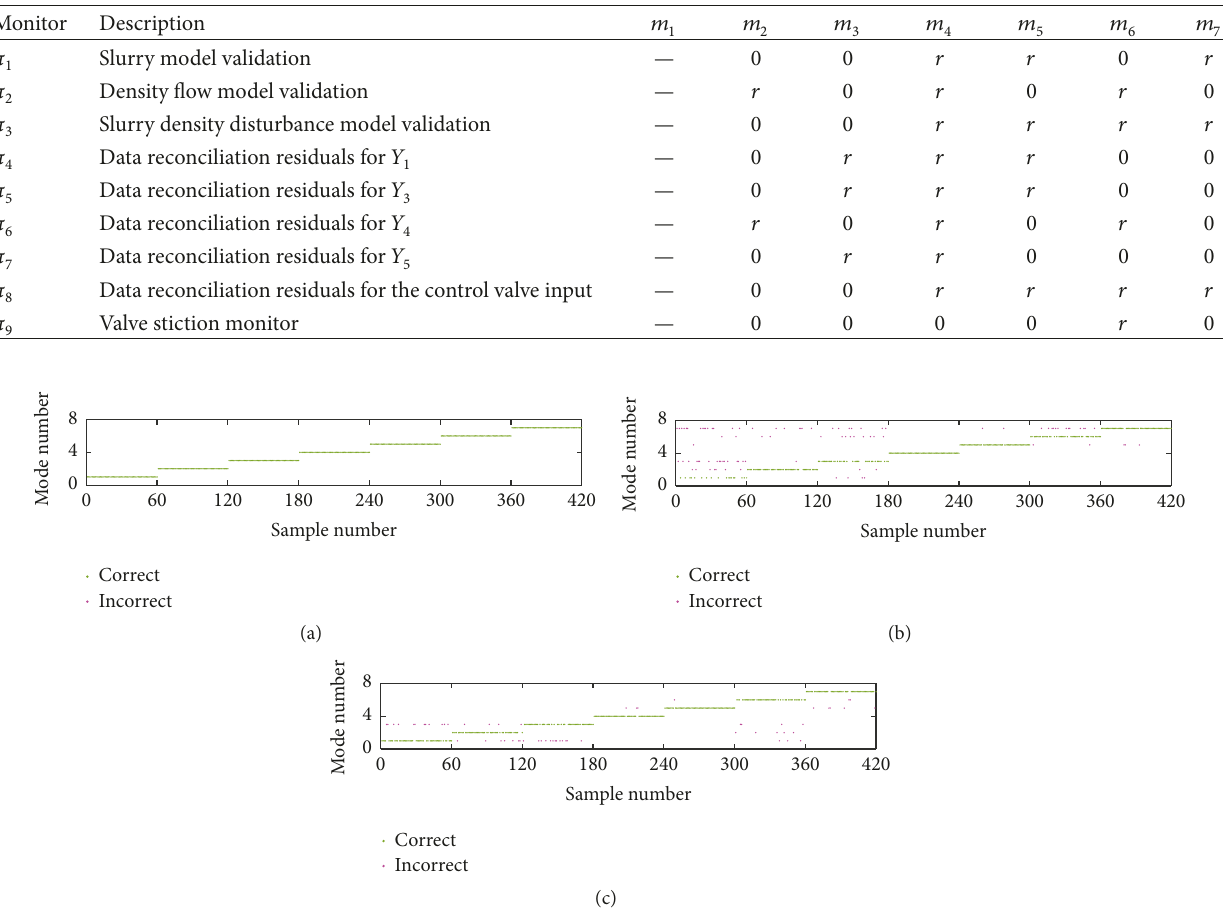
Figure 2: The underlying and diagnosed modes for each validating sample. (a) Underlying mode; (b) modes diagnosed using training data only; (c) modes diagnosed incorporating training data and response